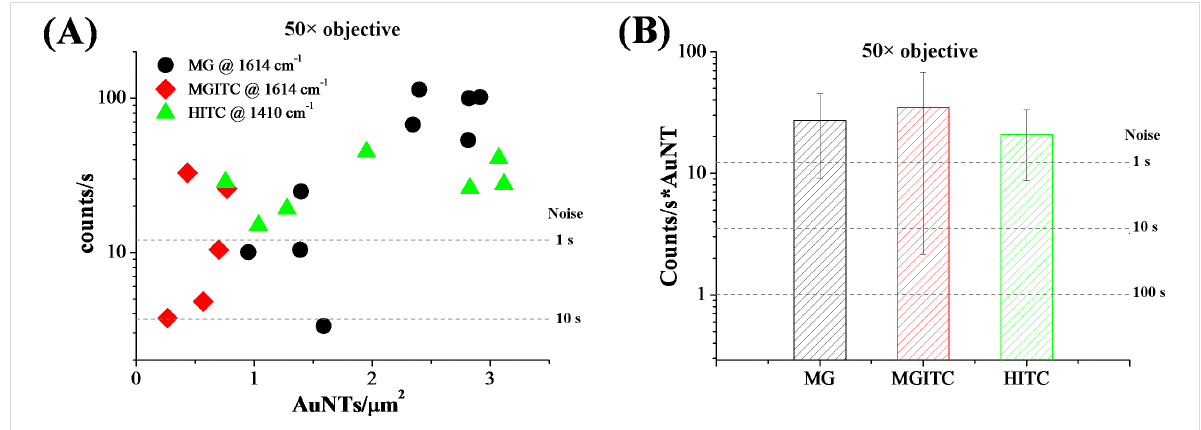
Figure 3: Results for Raman analysis with the 50× objective: (A) Counts per second versus AuNT surface density for MG (black circles), MGITC (red diamonds) and HITC (green triangles) labels. Each point in the graph corresponds to a different point on the TEM grid. (B) Mean value of the counts per second for single AuNT. Error bars represent the standard deviation. Dashed lines represent twice the noise level in the experimental conditions used and for various acquisition times.